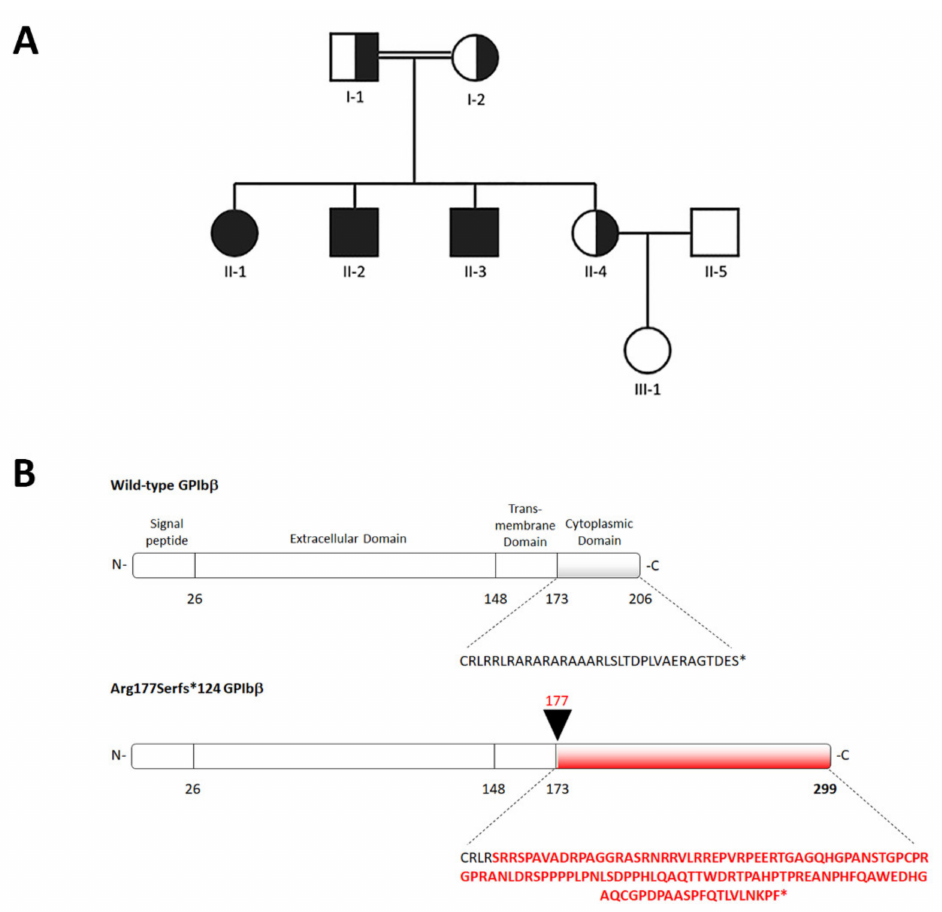
Figure 1. ( A ) Pedigree of the reported family, indicating the analyzed individuals. Black symbols indicate subjects carrying the GP1BB c.528_550del variant in homozygosis, and half-black symbols the heterozygous individuals. ( B ) Schematic representation of the sequence of the GPIb β protein induced by the GP1BB c.528_550del variant (p.Arg177Serfs*124). The new amino acid sequence of the tail domain generated by the frameshift variant is indicated in